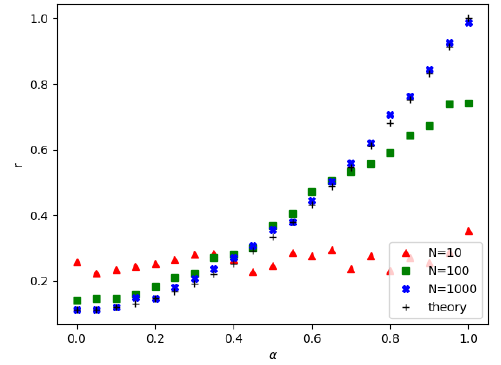
Figure 9. Comparison of purity when σ = 1.